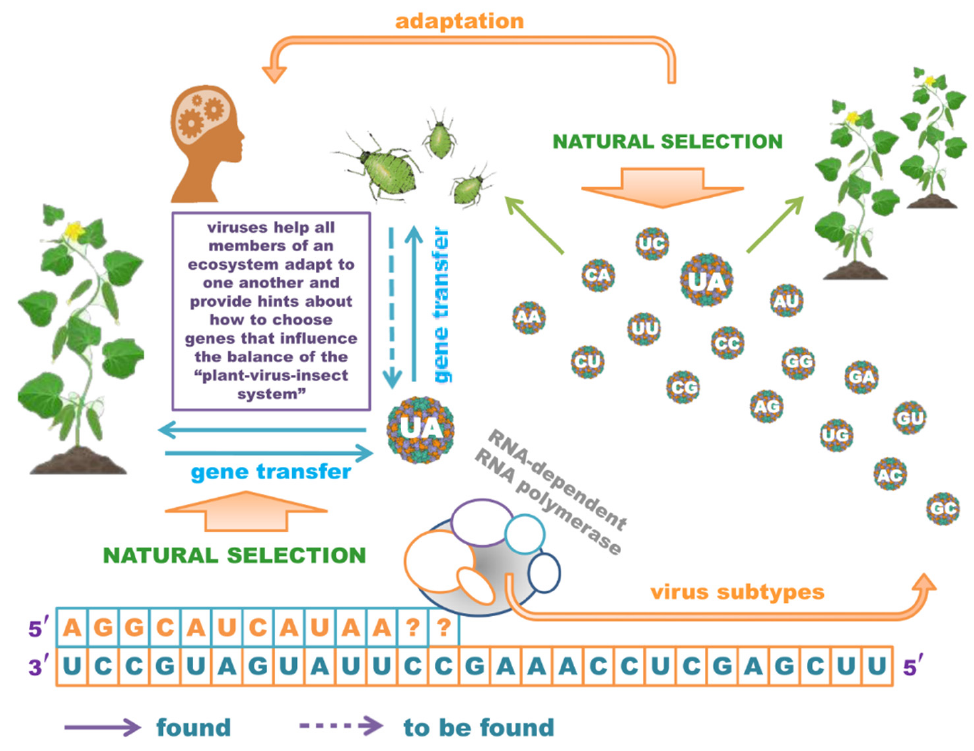
Figure 1. Tuning of ecosystems by ss(+)RNA viruses. This ability to move back and forth among the members of an ecosystem indicates the possibility that viruses are active participants in the genetic transformation of the genoplast of the community